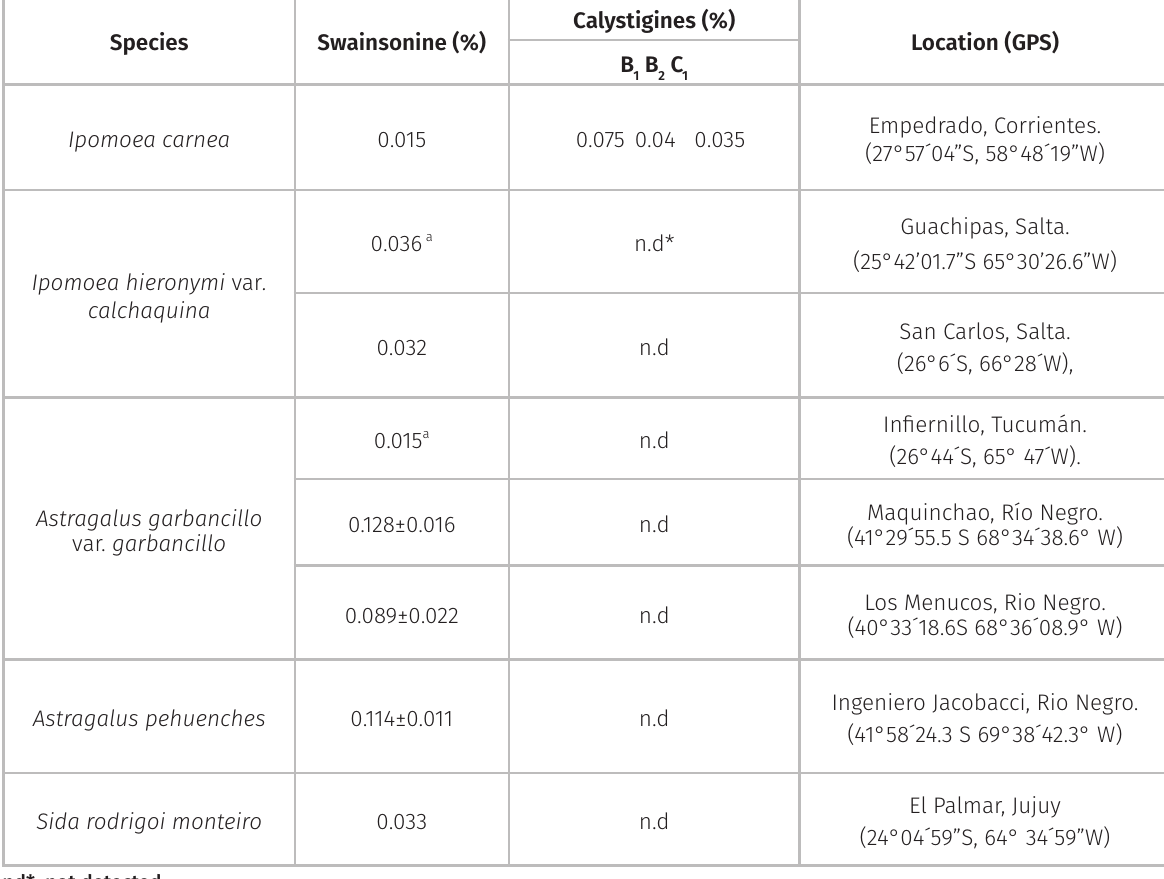
Table I. Swainsonine and Calystigines mean concentration (% of dry weight) in α-mannosidosis induced- plants from different regions of